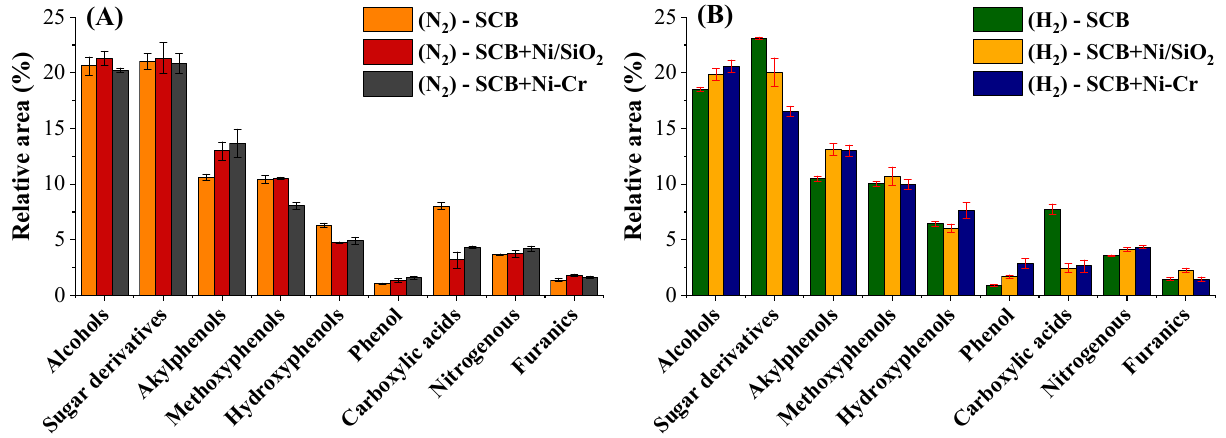
Figure 2. Histogram of classes of LLFs produced by ( A ) non-catalytic and catalytic pyrolysis, and ( B ) non-catalytic and catalytic hydropyrolysis.